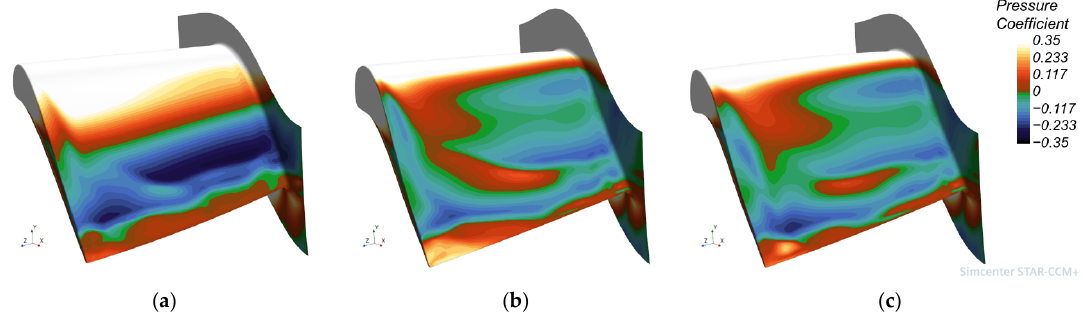
Figure 12. Static pressure distributions: ( a ) Baseline design; ( b ) Design A; and ( c ) Design B. Next, the pressure coefficient distributions on the blade surfaces are investigated.